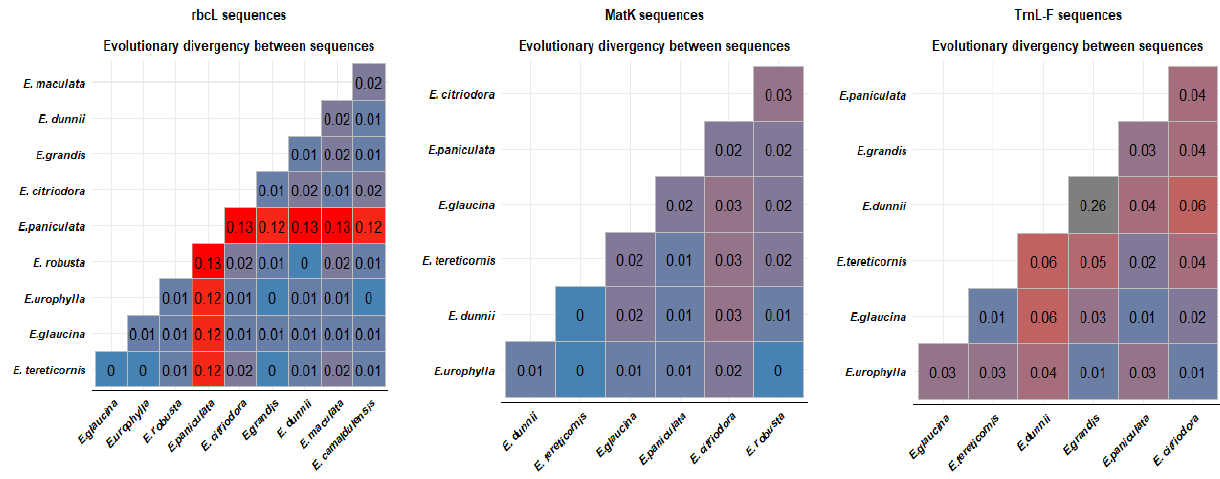
Figure 4. Evolutionary divergence between sequences.